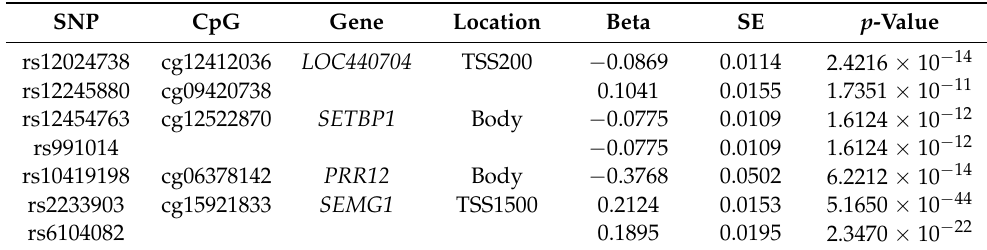
Table 3. Blood methylation quantitative loci (blood-meQTL).